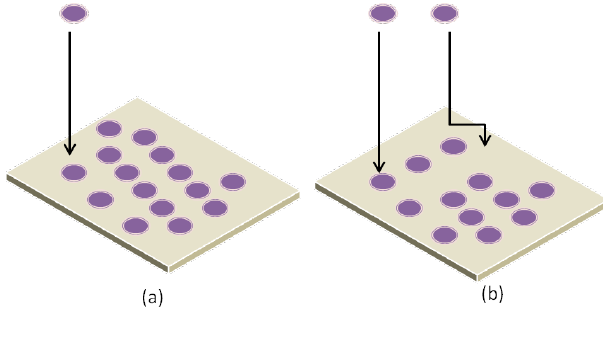
Figure 12. Non-cooperative and Cooperative adsorption mechanisms. ( a ) Non-cooperative adsorption: proteins track vertically towards the surface; ( b ) Cooperative adsorption: proteins track vertically and horizontally towards the